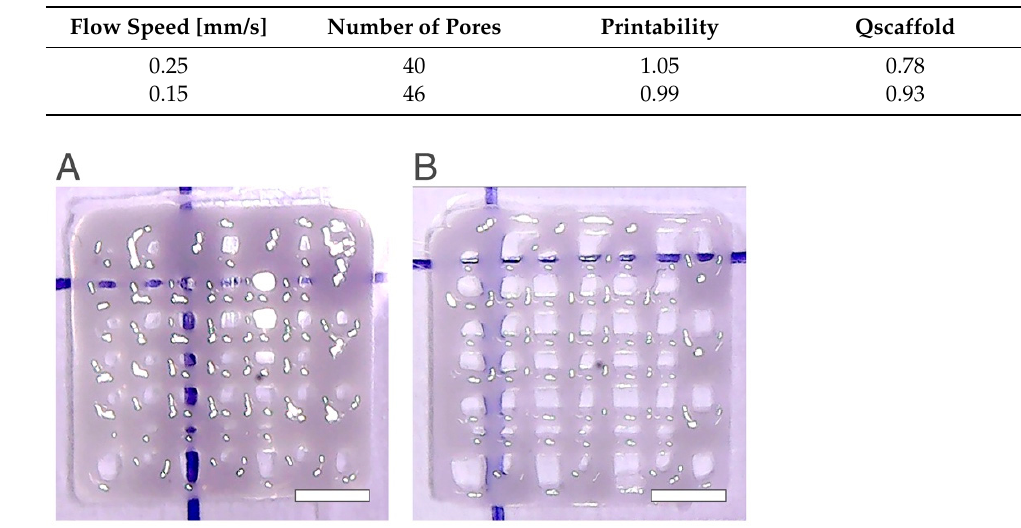
Table 3. Number of pores, printability and Qscaffold obtained using chitosan 2.5 wt% and starch 13 wt% with a layer height of 0.41 mm, applying different flow speed values.